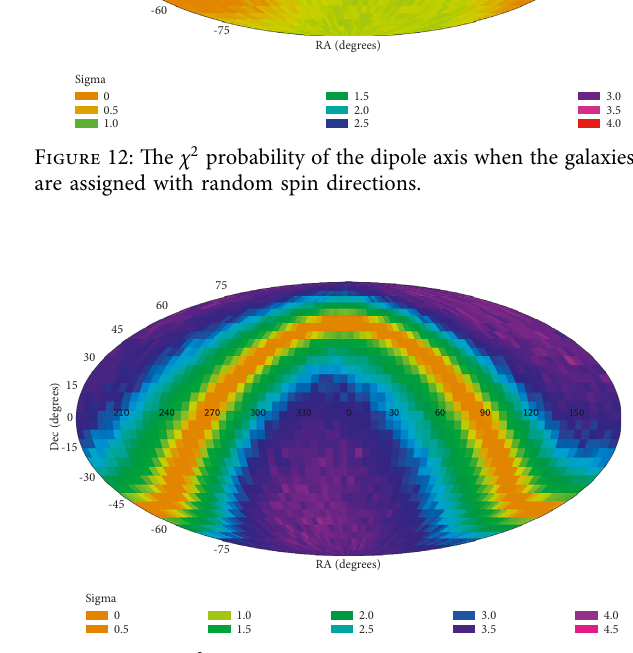
Figure 13: The χ 2 probability of the dipole axis when using the dataset of 13,440 manually annotated SDSS galaxies.